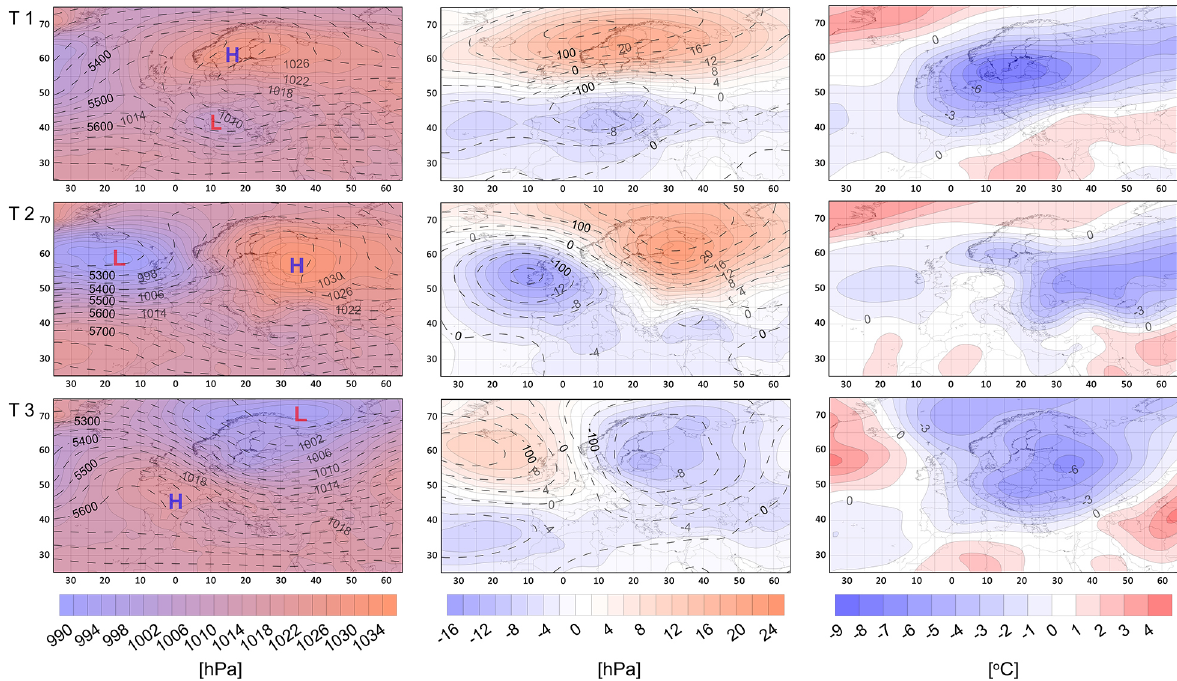
Fig. 5. Mean SLP [in hPa] (colour scale) and z500 hPa [in gpm] (dotted line) (left column); SLP [in hPa] (colour scale) and z500 hPa anomalies [in m] (dotted line) (middle column); and anomalies of T850 [in °C] (right column) for the designated circulation types. SLP, sea level